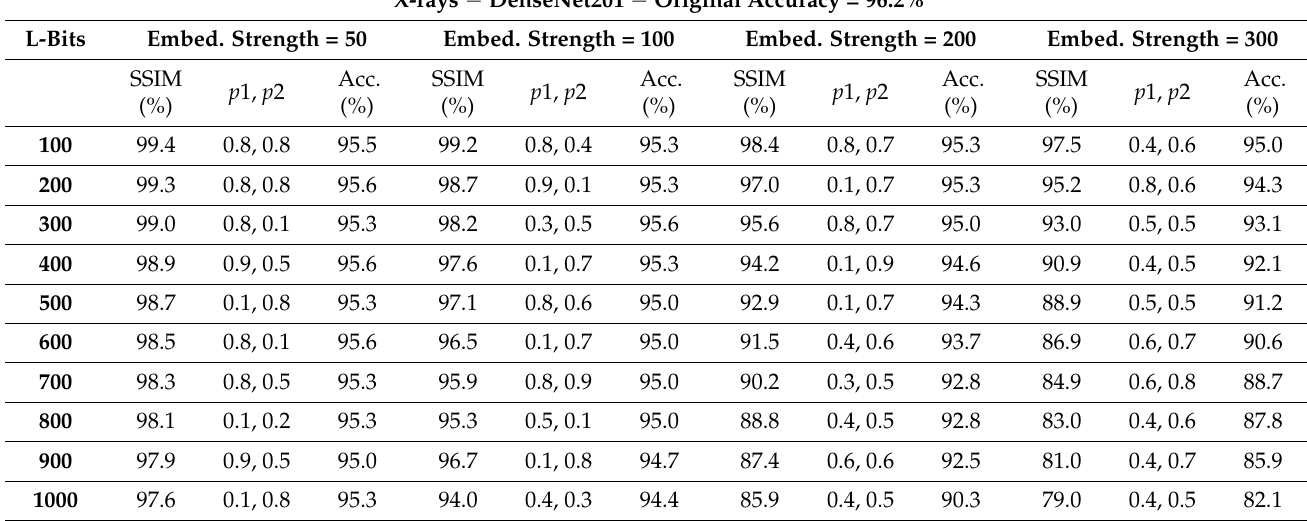
Table 2. KMsWA 2 attack on DenseNet201 in